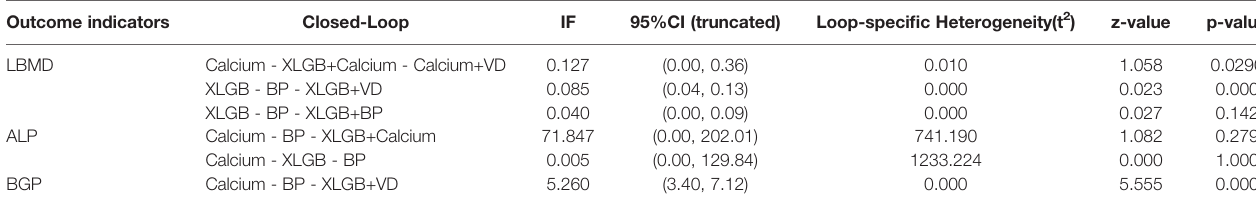
TABLE 6 | Results of the closed-loop inconsistency test.